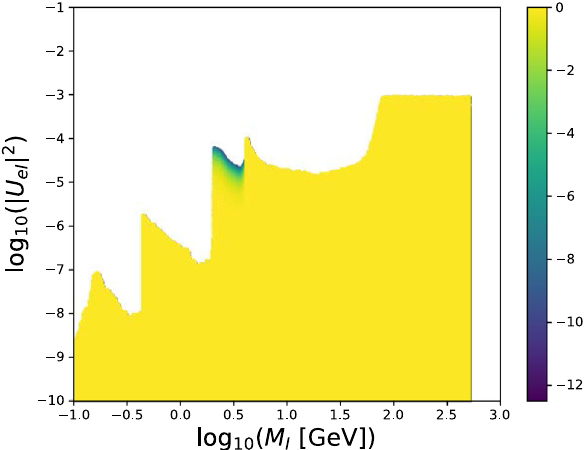
Fig. 21 Partial likelihood from the long-lived particle searches with DELPHI, in the M I − | U eI | 2